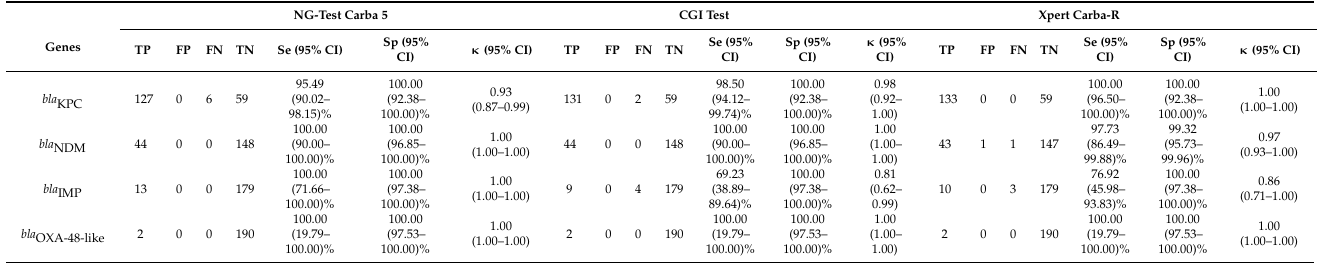
Table 1. Comparison of the NG-test Carba 5, colloidal gold immunoassay (CGI) test, and Xpert